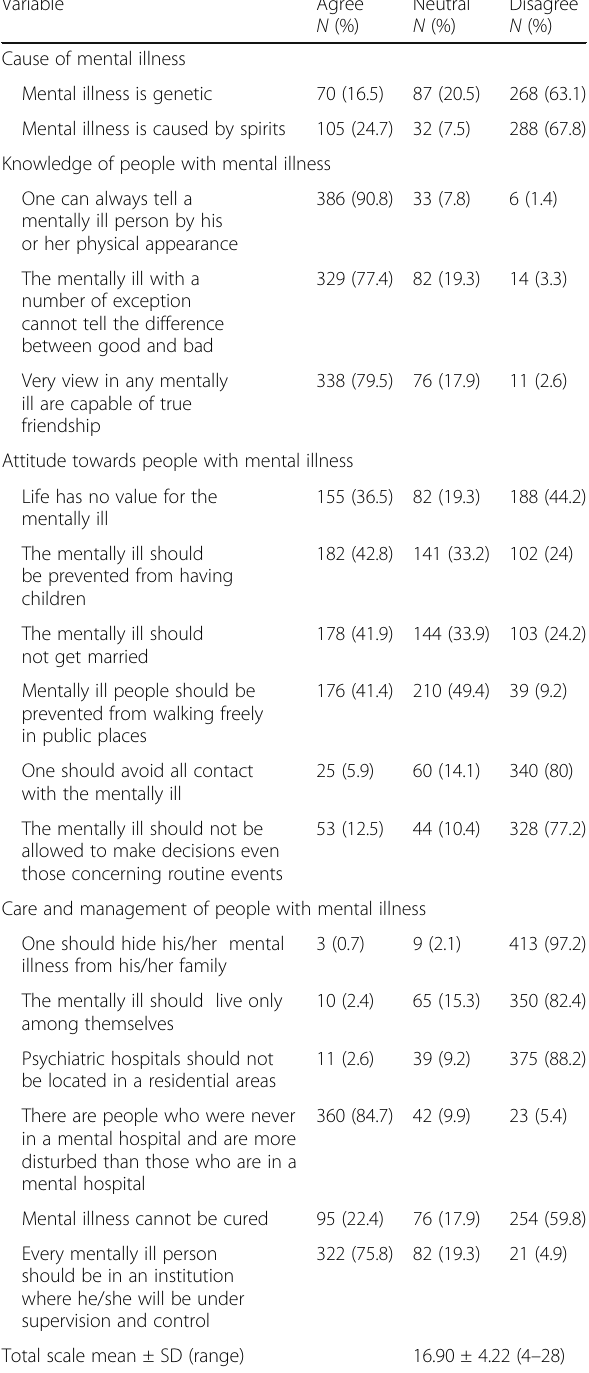
Table 3 Pattern of traditional healers ’ management for the Table 4 Modified Attitude towards Mental Illness studied mentally ill patients, Assiut University Hospitals 2017 No. ( n = 341) Percent Type of traditional healers management for patient illness (either traditional healer only or both traditional and non-psychiatric physician)*